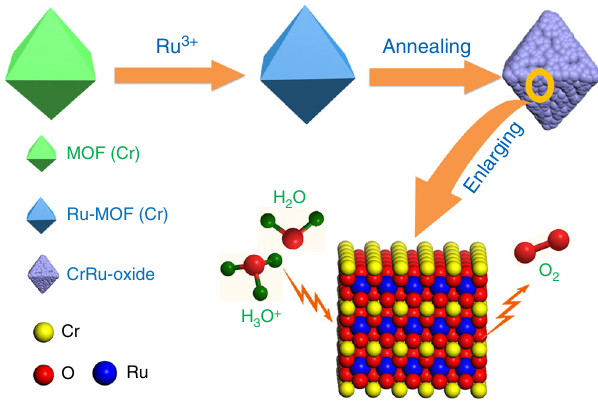
Fig. 1 Schematic illustration of the preparation of Cr 0.6 Ru 0.4 O 2 electrocatalysts for OER application in acid